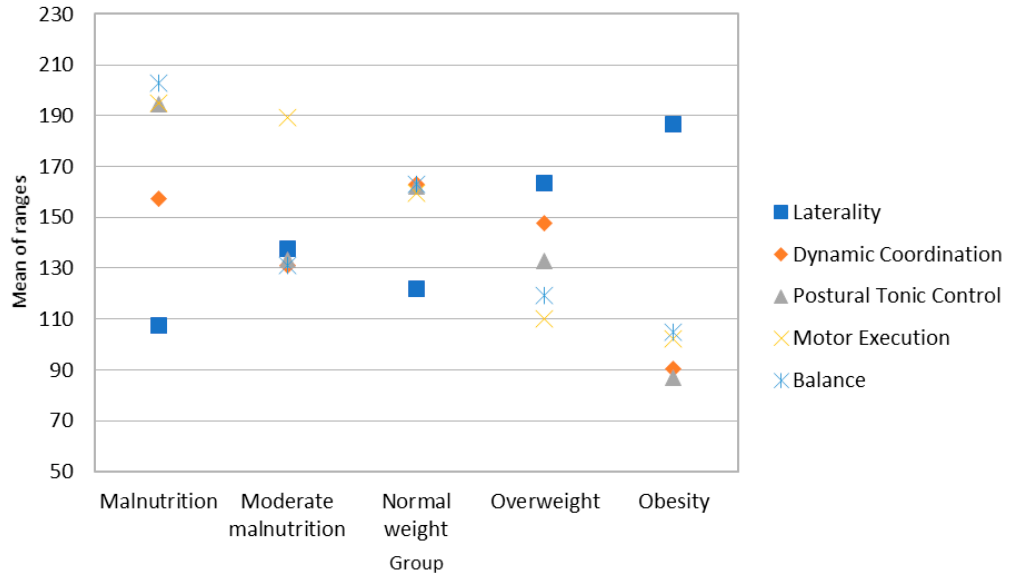
Figure 1. Average range of the scores for motor skills in the sample of girls.